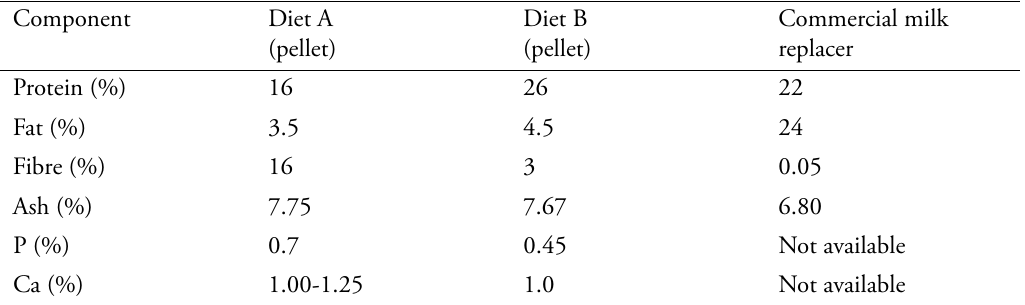
Table 1. Dietary analysis of pelletised feed and powdered milk replacer used for the translocation. Infor- mation provided by the manufacturer of pelletised feed (W. & H. Marriages & Sons Ltd, Chelmsford, Es- sex, UK) and commercial sheep milk replacer (SCA Nutrition Ltd, Thirsk, North Yorkshire,